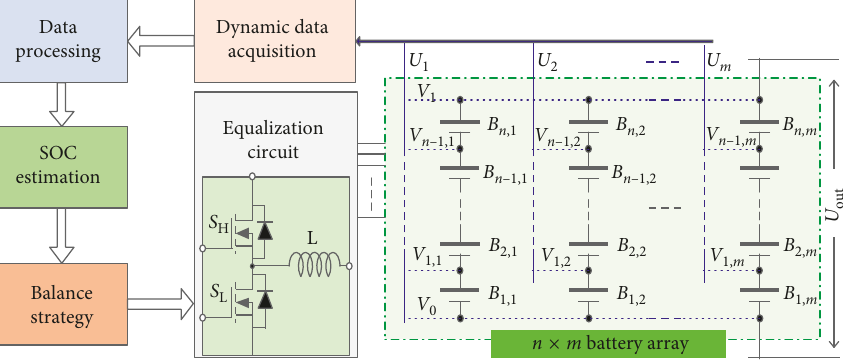
Figure 1: Equalization system block diagram.